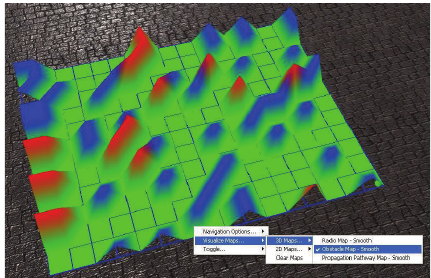
Figure 10: 3D representation of industrial hall